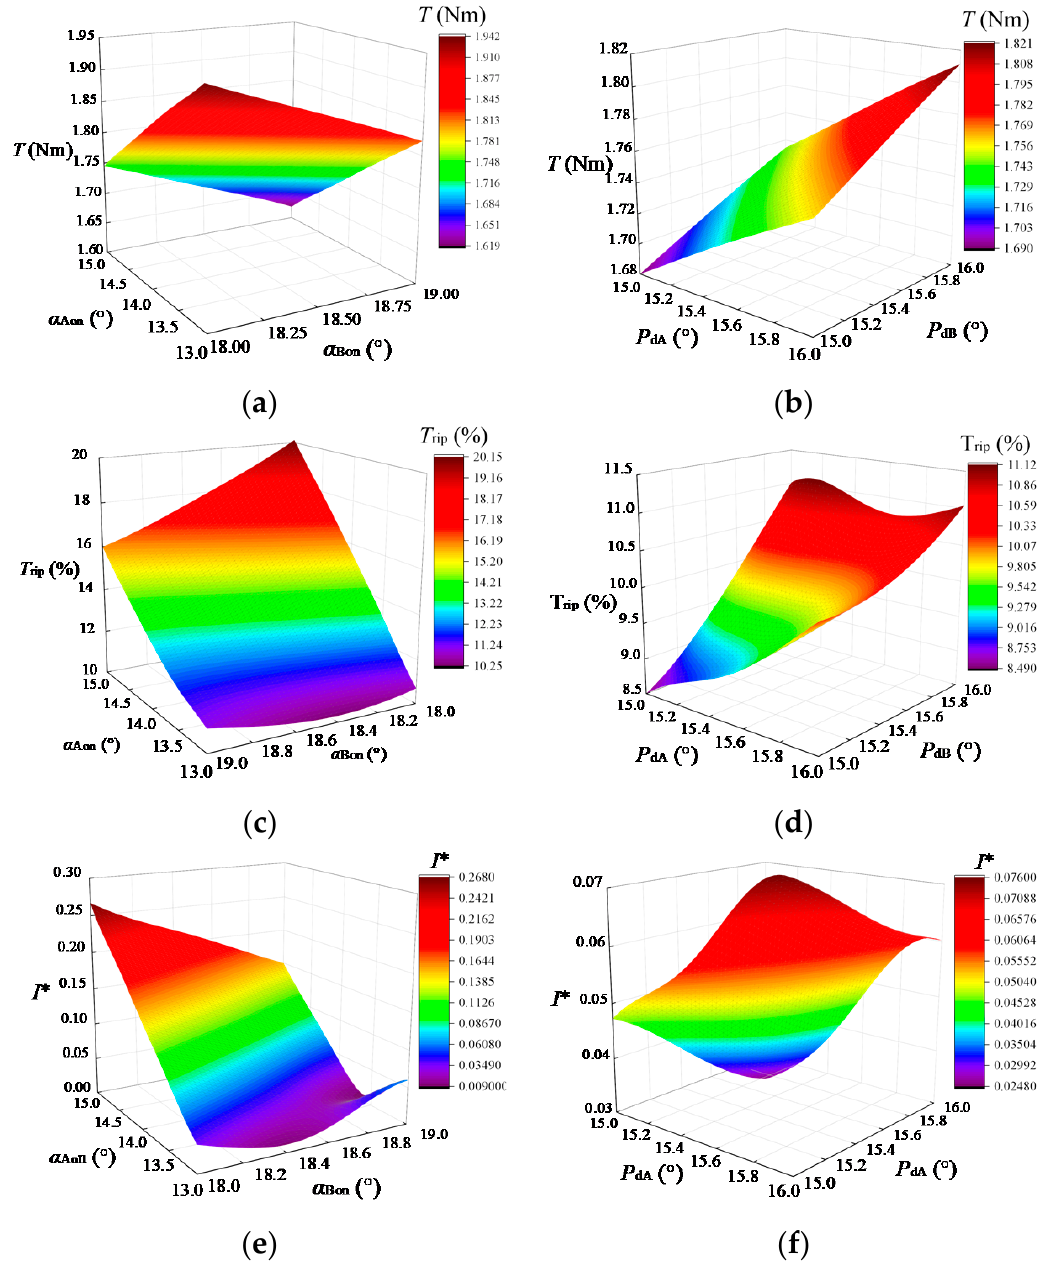
Figure 5. Relationships between ( a ) T , α Aon, and α Bon , ( b ) T , P dA , and P dB , ( c ) T rip , α Aon , and α Bon , ( d ) T rip , P dA , and P dB , ( e ) I* , α Aon , and α Bon , and ( f ) I* , P dA, and P dB .